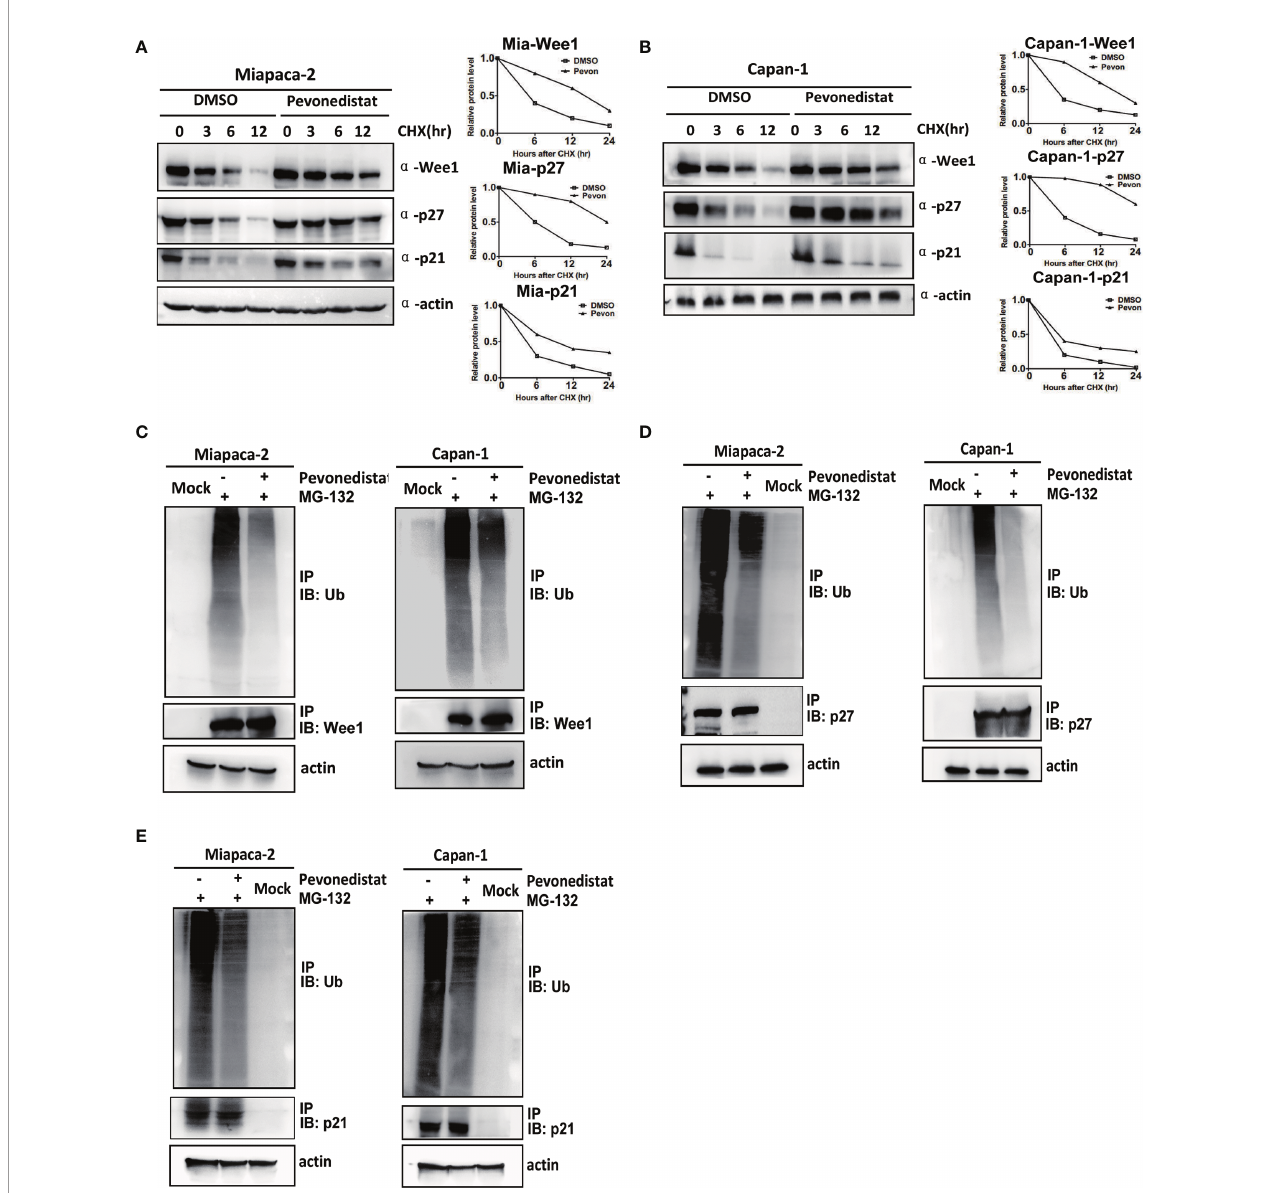
FIGURE 5 | Pevonedistat reduced the ubiquitination levels of Wee1, p27, and p21, and prolonged their half-lives in pancreatic cancer cells. (A) Pevonedistat extended the half-lives of Wee1, p27, and p21 in Miapaca-2 cells. Cells were pretreated with pevonedistat for 24 h; then further treated by 1.0 m M of pevonedistat vs. dimethyl sulfoxide (DMSO) in combination with 50 m g/ml CHX for 0, 3, 6, and 12 h; and subjected to immunoblotting using antibodies against Wee1, p27, and p21 with actin as a loading control. The protein level was quanti fi ed by densitometry. Two-sided t-test. (B) Pevonedistat prolonged the half-lives of Wee1, p27, and p21 in Capan-1 cells. Cells were pretreated with pevonedistat for 24 h; then further treated by 1.0 m M of pevonedistat vs. dimethyl sulfoxide (DMSO) in combination with 50 m g/ml CHX for 0, 3, 6, and 12 h; and subjected to immunoblotting using antibodies against Wee1, p27, and p21 with actin as a loading control. The protein level was quanti fi ed by densitometry. Two-sided t-test. (C) Pevonedistat decreased the ubiquitination level of Wee1. Miapaca-2 and Capan-1 cells were treated with 1.0 m M of pevonedistat vs. DMSO for 24 h, then combined with 5 m M of MG-132 for more than 24 h, and subjected to immunoprecipitation using anti-Wee1 or rabbit IgG control antibody and immunoblotting using anti-ubiquitin antibody with actin as a loading control. (D) Pevonedistat reduced the ubiquitination level of p27. Miapaca-2 and Capan-1 cells were treated with 1.0 m M of pevonedistat vs. DMSO for 24 h, then combined with 5 m M of MG-132 for more than 24 h, and subjected to immunoprecipitation using anti-p27 antibody or rabbit IgG control antibody and immunoblotting using anti-ubiquitin antibody with actin as a loading control. (E) Pevonedistat attenuated the ubiquitination level of p21. Miapaca-2 and Capan-1 cells were treated with 1.0 m M of pevonedistat vs. DMSO for 24 h, then combined with 5 m M of MG-132 for more than 24 h, and subjected to immunoprecipitation using anti-p21 antibody or rabbit IgG control antibody and immunoblotting using anti-ubiquitin antibody with actin as a loading control. These data were representative of three independent experiments. Data represent means, and error bars are SD. Two-sided